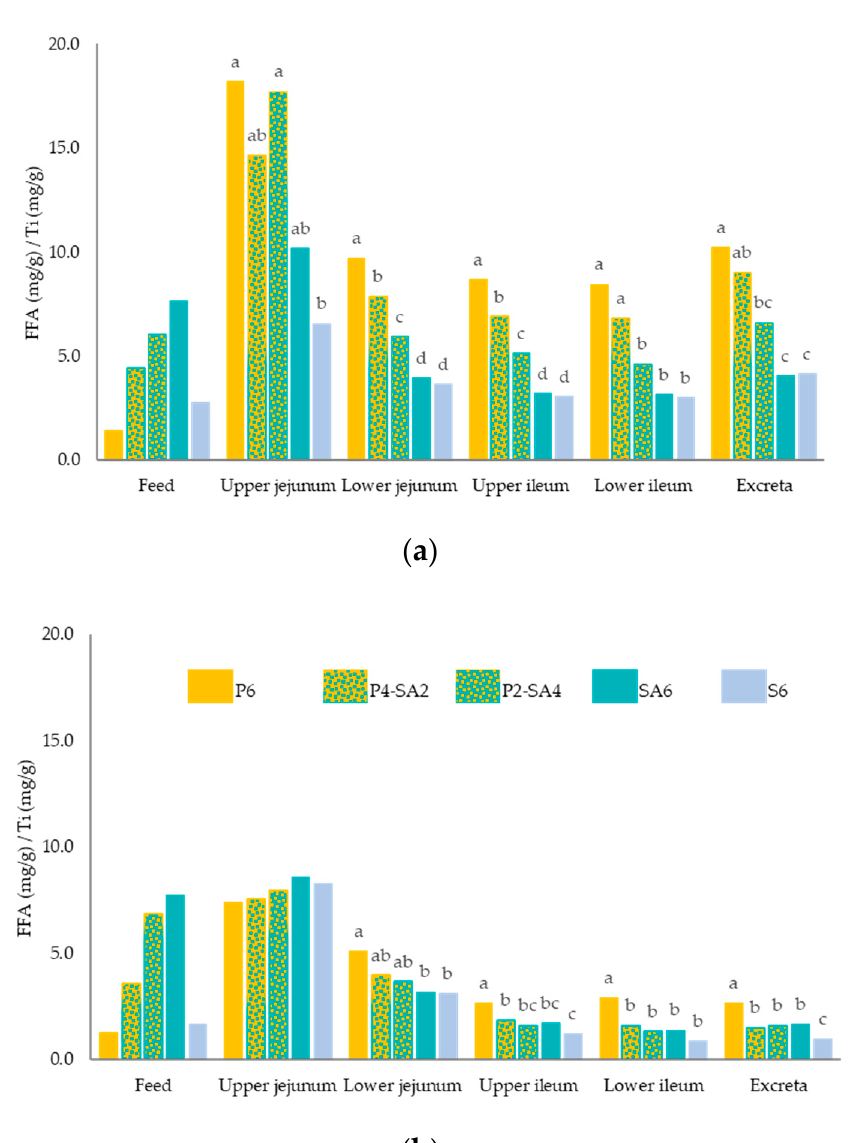
Figure 1. Free fatty acids (FFA) content 1 in the feed, upper jejunum, lower jejunum, upper ileum, lower ileum, and excreta for the five different diets; with 6% of palm oil (P6), blend with 4% palm oil +2% soybean acid oil (P4-SA2), blend with 2% palm oil +4% soybean acid oil (P2-SA4), with 6% of soybean acid oil (SA6) and with 6% soybean oil (S6) in ( a ) 11-d-old broiler chickens and ( b ) 35-d-old broiler chickens. 1 FFA concentration (mg/g)/Ti concentration (mg/g) in each intestinal segment and excreta. Per each diet, means values are obtained from means of 6 replicates with 12 chickens/replicate at 11 d, and 2 chickens/replicate at 35 d. a–d: for each intestinal segment and excreta, different letter indicates significant differences ( p ≤ 0.05).